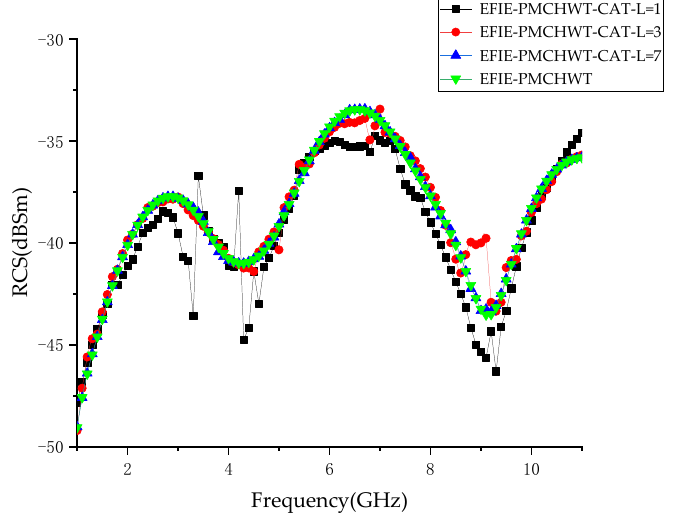
Figure 15. RCS frequency response of the coated missile by using three different orders of EFIE- PMCHWT-CAT and EFIE-PMCHWT.